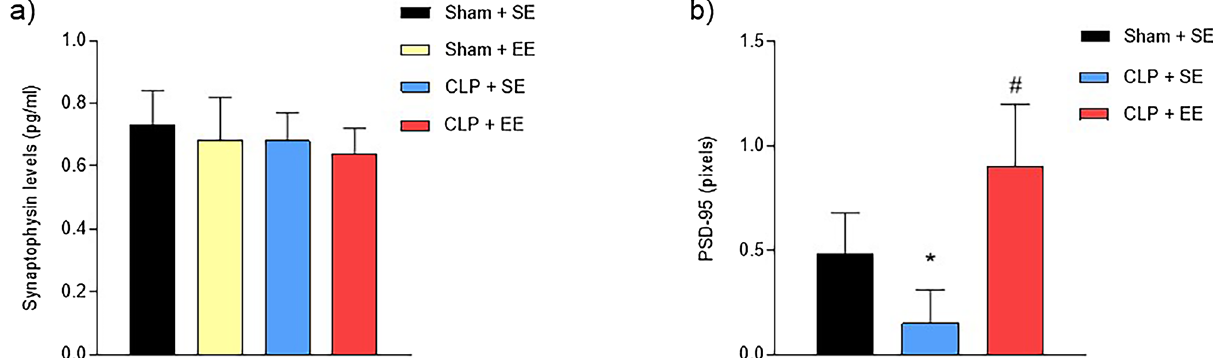
Figure 10. ( a ) Synaptophysin levels in the hippocampus after the environmental enrichment protocol in animals subjected to sepsis. Synaptophysin levels were measured at the end of the environmental enrichment protocol in the hippocampus of animals subjected to sepsis. The data were expressed as mean ± SD and compared with one-way analysis of variance (ANOVA) followed by the Tukey test. nº = 6 each group. ( b ) PSD-95 levels in the hippocampus after the environmental enrichment protocol in animals submitted to sepsis. PSD-95 levels were measured at the end of the environmental enrichment protocol in the hippocampus of animals subjected to sepsis. The data were expressed as mean ± SD and compared with one-way analysis of variance (ANOVA) followed by the Tukey test. nº = 6 each group. * p < 0.05 different from sham + SE; # different from CLP + SE. EE: environmental enrichment; SE: standard